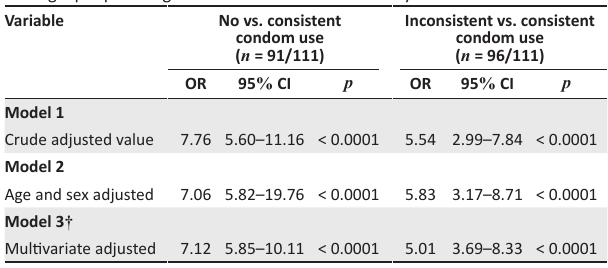
TABLE 4 : Results of unadjusted and adjusted multinomial logistic regression to assess the relation between depression and not continuously using condoms amongst people living with human immunodeficiency virus.